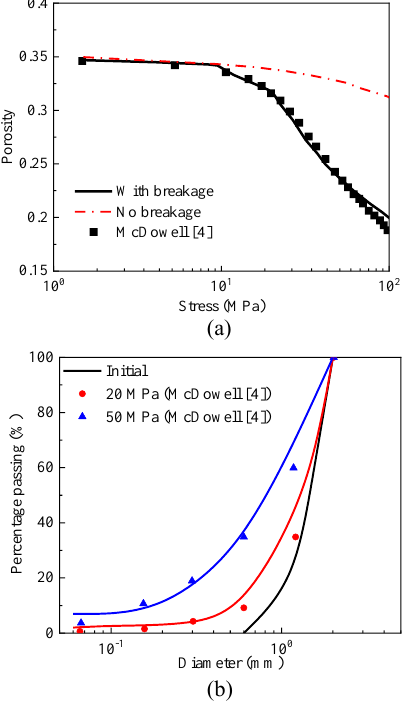
Fig. 2 Comparison of (a) compaction curves and (b) PSD for silica sand. The dots and lines represent the experiment and simulation data, respectively.